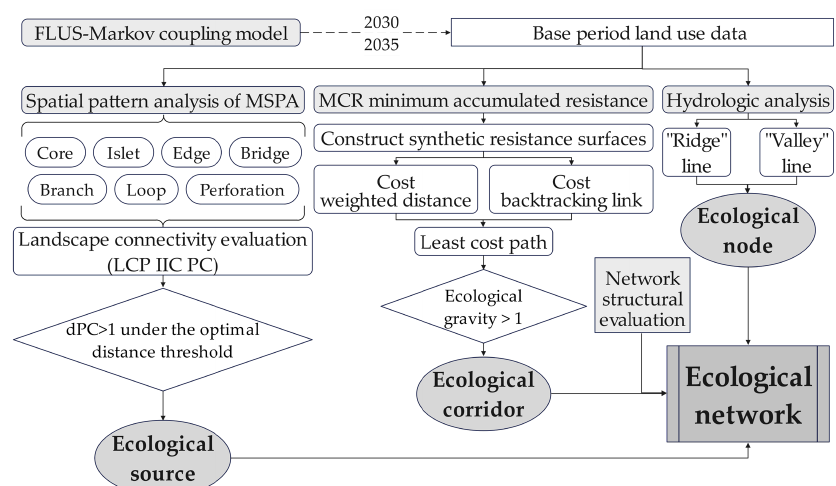
Figure 2. A flow chart depicting the analytical process of the research methodology. Table 1. Parameter settings of the FLUS − Markov coupling